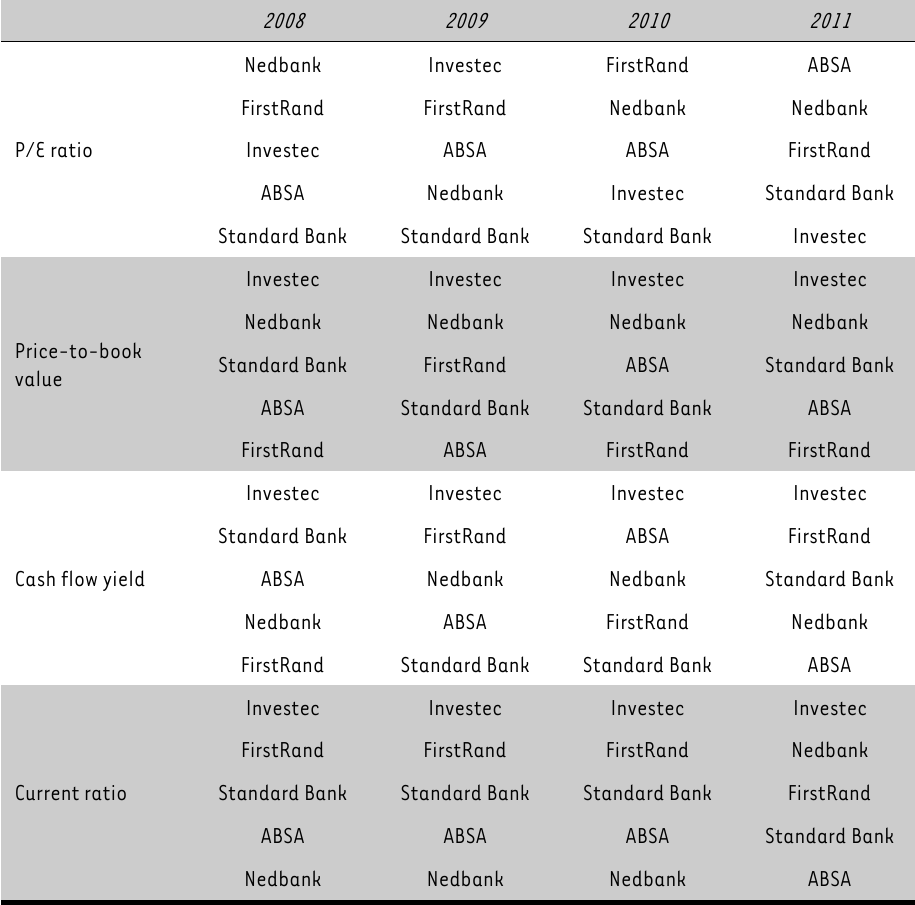
Summary of the financial measures (ranked from best to